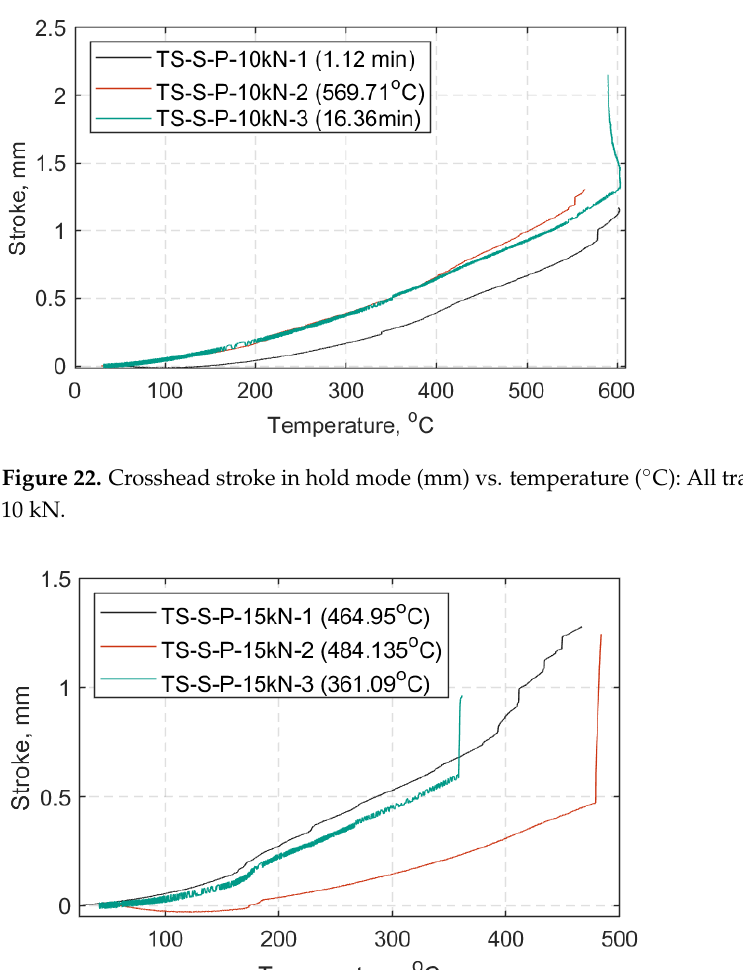
Figure 24. Crosshead stroke in hold mode (mm) vs. temperature (°C): All TS cases at 20 kN.